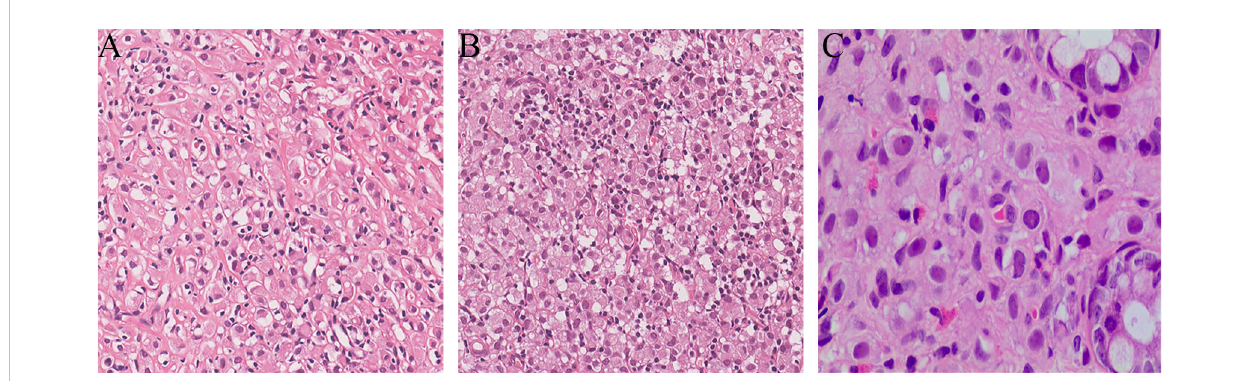
FIGURE 3 Ultrasound-guided percutaneous biopsy for the 68 Ga-DOTATATE-avid left axilla and right inguinal lymph nodes. The pathological results revealed metastatic invasive lobular breast carcinoma ( A , left axillary lymph node, HE×200; B , right inguinal lymph node, HE×200). The rectal polyp con fi rmed metastatic carcinoma of suspected breast origin ( C , rectum polyp,